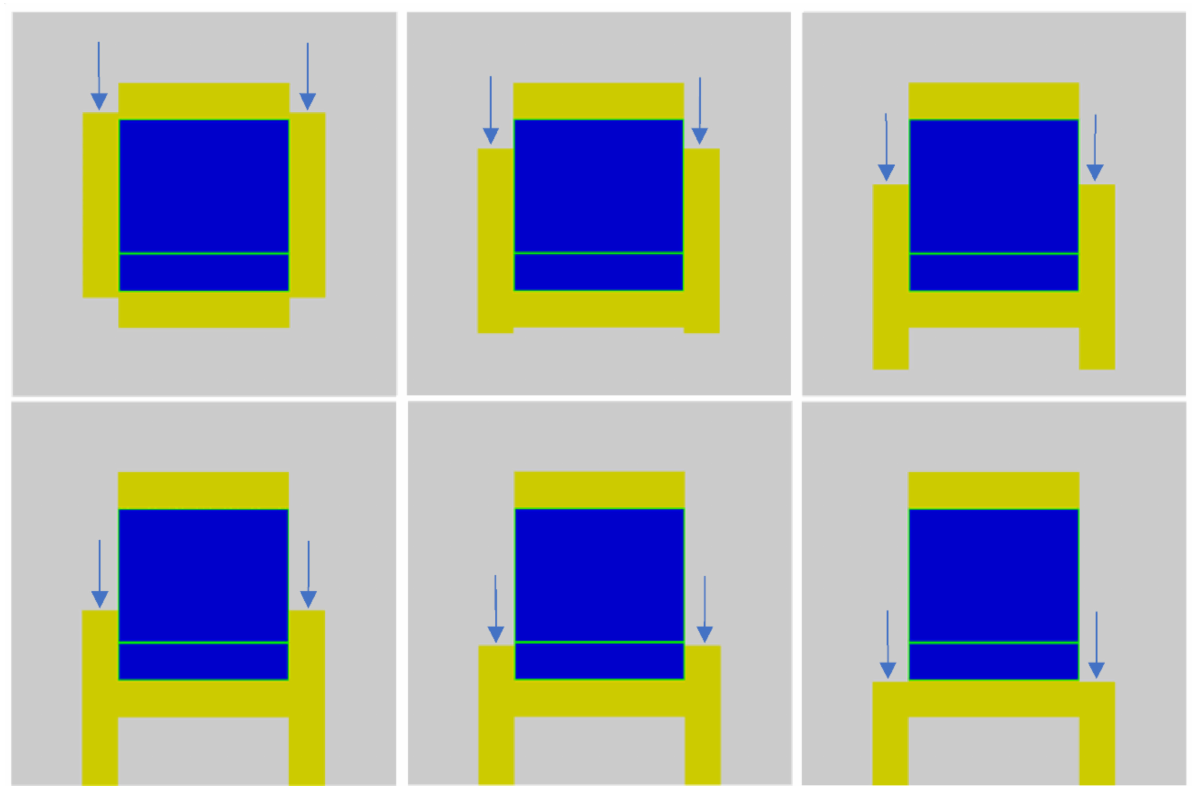
Figure 9. Different steps of reflector movement steps with increased downward movement from top left to bottom right (top from left to right 0 cm, − 30 cm, and − 60 cm, bottom left to right − 90 cm, − 120 cm, and − 150 cm) for the analysis of the reactivity curve related to the movement of the reflector.